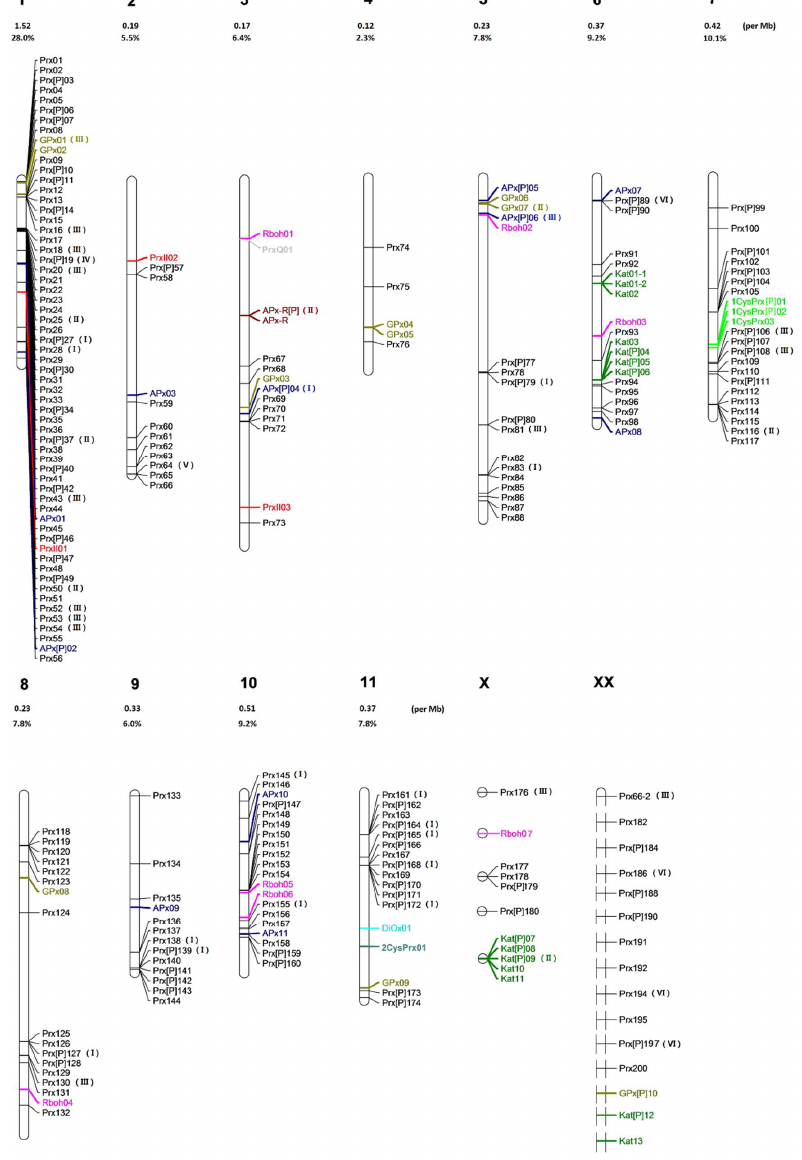
Figure 2. Genomic localization of the ROS gene families from E. grandis . All the predicted ROS genes annotated from the genomic program including complete sequences, partial sequences and pseudogenes which can be located on the 11 chromosomes are presented. This synthetic chromosomal localization was displayed by MapChart 2.1. New sequences obtained from cloning strategies are not localized. Different colors represent different families. (I) E. grandis specific genes compared to E. camaldulensis . (II) E. grandis specific genes compared to E. globulus . (III) E. grandis specific genes compared to E. gunnii . (IV) E. grandis specific genes compared to E. camaldulensis , E. globulus and E. gunnii . (V) E. grandis specific genes compared to E. camaldulensis and E. gunnii . (VI) E. grandis specific genes compared to E. globulus and E. gunnii . The 11 chromosomes are labelled with 1–11 above each chart. The genes on small sca ff olds are visualized on ‘chromosome’ X. The newly found genes without position information are visualized on ‘chromosome’ XX. The ROS gene concentration (ROS gene number per Mb chromosome) and the % of ROS genes on each chromosome (ROS gene number on the chromosome / total ROS gene number in E. grandis ) are written above the chart without considering the genes on ‘chromosome’ X and ‘chromosome’ XX. The concentration is calculated as formula: gene number / size of the